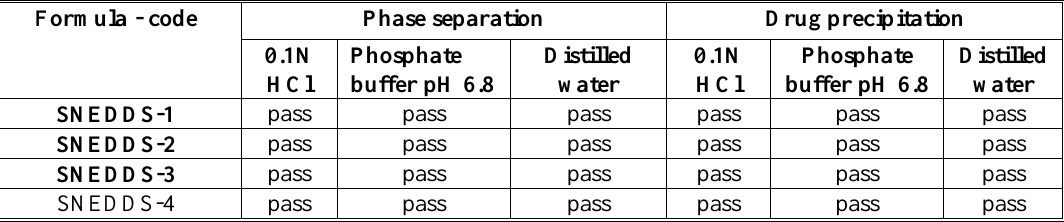
Table 6. Robustness to dilution of various bromocriptine mesylate liquid self-nanoemulsifying drug delivery